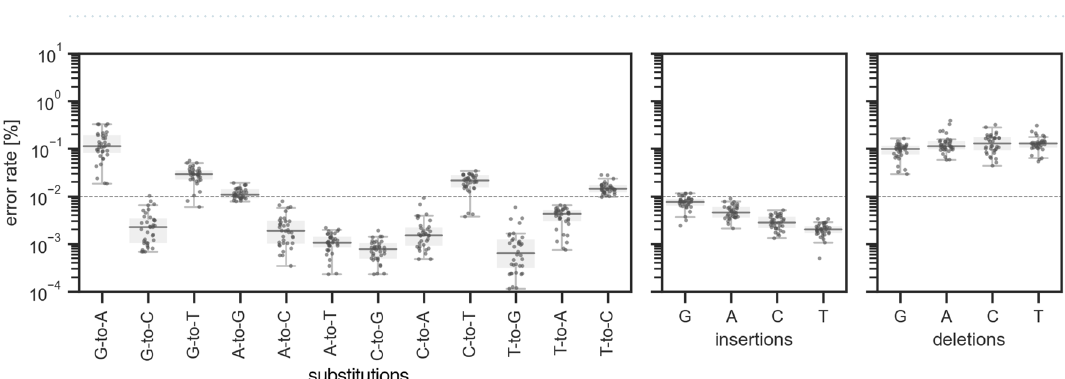
Figure 5. Error rates for substitutions, insertions, and deletions during standard oligonucleotide synthesis. The data were obtained from three independently synthesized oligonucleotides. The synthetic conditions are 1 H -tetrazole in anhydrous acetonitrile as an activator, acetic anhydride in THF as a capping reagent A, 10% 1-methylimidazole in 10% pyridine-THF as a capping reagent B, 0.02 M I 2 in THF/pyridine/H 2 O (90:<1:10, v/v/v) as an oxidation reagent, and 3% trichloroacetic acid in dichloromethane (TCA) as a deblocking reagent. Q5 High-Fidelity DNA polymerase was used for assembling